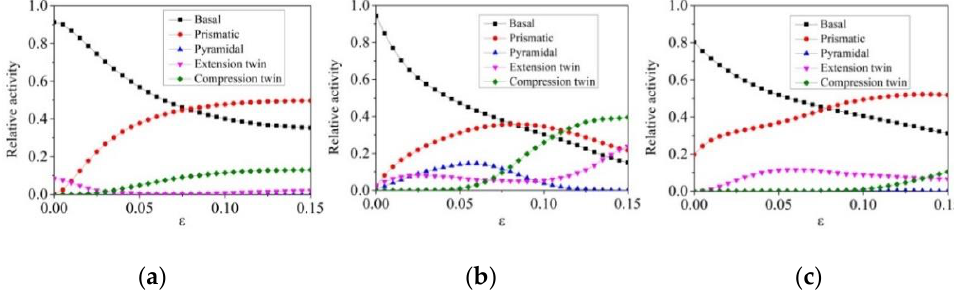
Figure 5. VPSC predicted relative activity of deformation modes under uniaxial tension of different samples: ( a ) T0 sample, ( b ) T45 sample, ( c ) T90 sample. samples: ( a ) T0 sample, ( b ) T45 sample, ( c ) T90